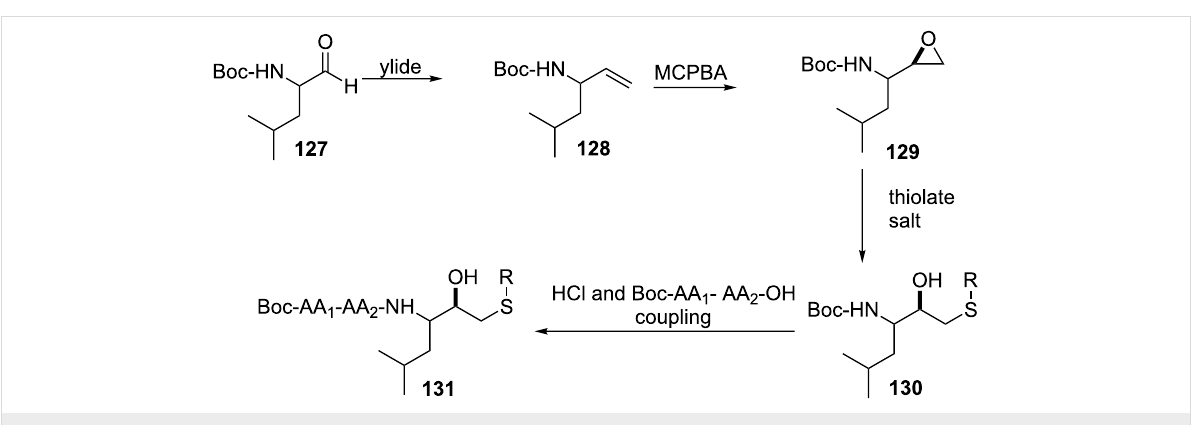
Scheme 44: Synthesis of peptides containing a β -hydroxy sulfide